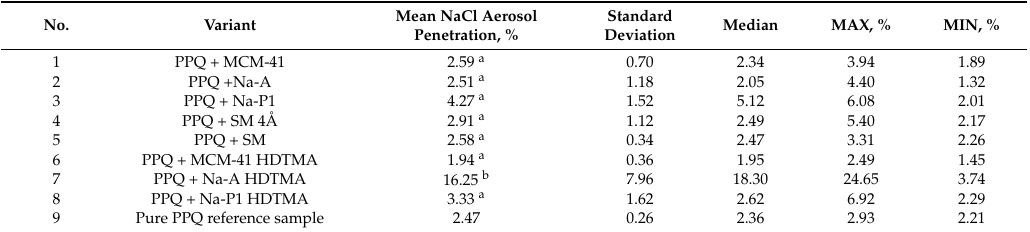
Table 4. Mean NaCl aerosol penetration for nonwoven composites containing zeolite and silica materials (descriptive statistics).